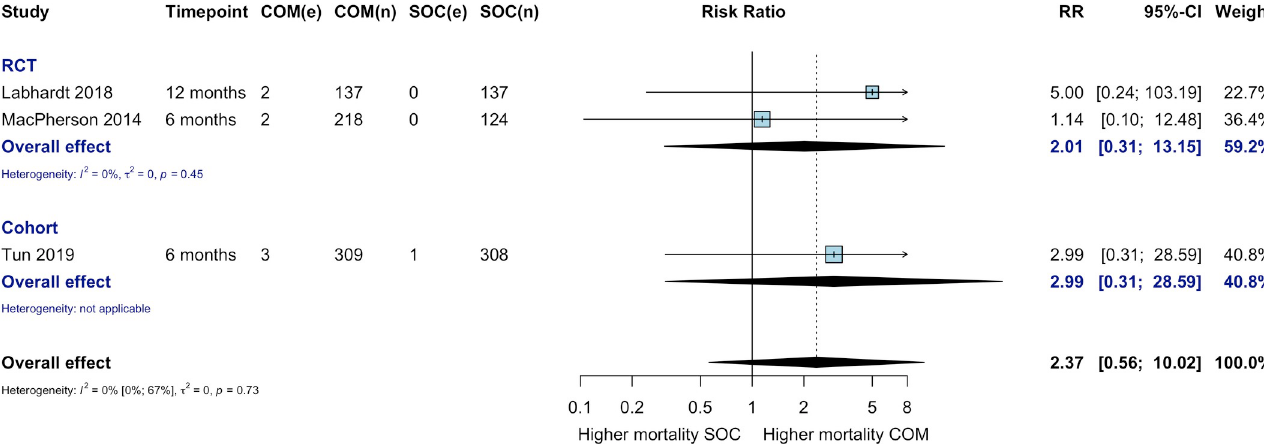
Fig 8. Mortality among HIV-positive individuals at 12 months. COM, community ART initiation; e, number of events; n, number of participants; RCT, randomized controlled trial; RR, risk ratio; SOC, standard of care. https://doi.org/10.1371/journal.pmed.1003646.g008 PLOS Medicine| https://doi.org/10.1371/journal.pmed.1003646 May 28,